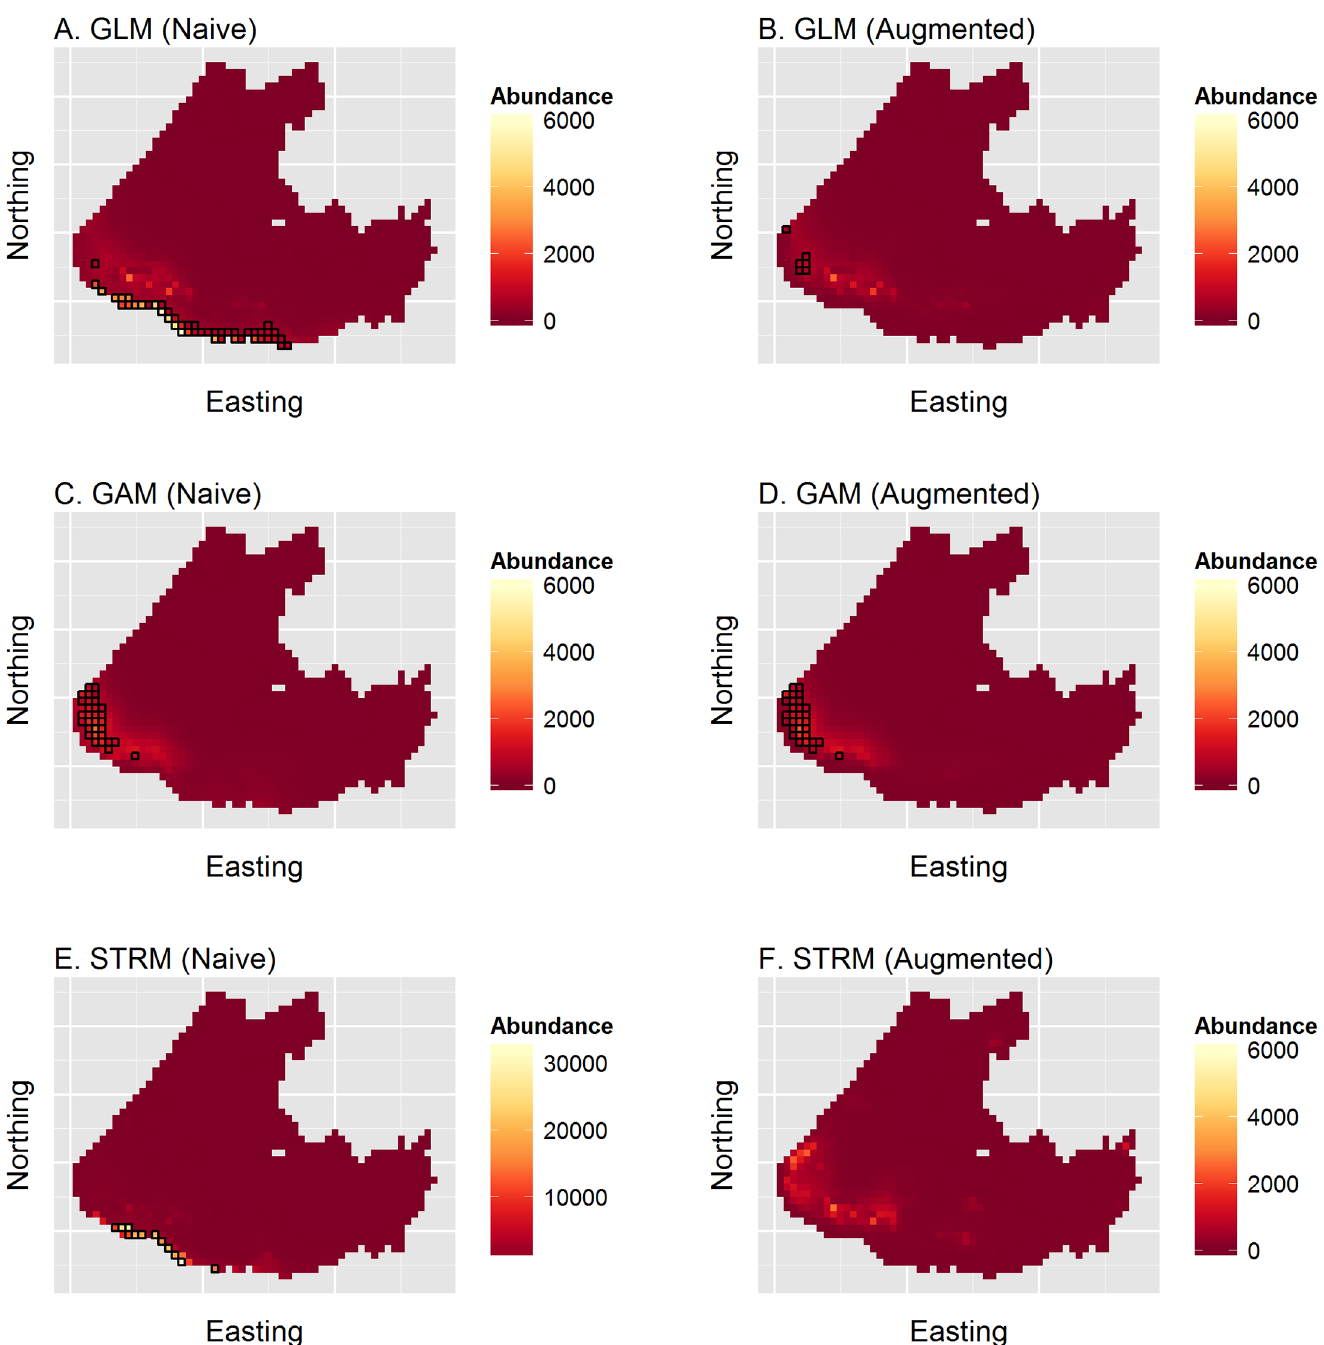
Fig 5. Predictions of ribbon seal apparent abundance across the eastern Bering sea from models fit to survey data. Predictions were obtained using the posterior predictive mean for GLM and STRM models, and for the GAM using the predict.gam function in the R mgcv package [7]. Each row gives result for different model types (GLM, GAM, or STRM, respectively); left column plots give results for naive runs without presumed absences, while plots in the right column give predictions for runs where presumed absence data (i.e., 0 counts in cells with < 0.1% ice) were included. Cells highlighted in black indicate those where predictions were outside the generalized independent variable hull